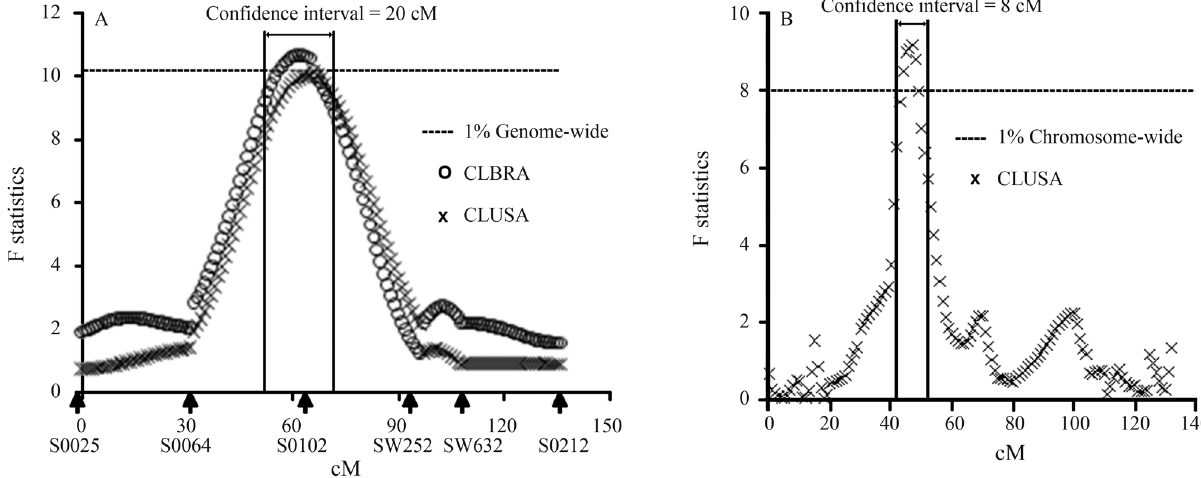
Figure1 -ExampleofconfidenceintervalreductionfromA(QTLforCLUSAfromSousa etal.